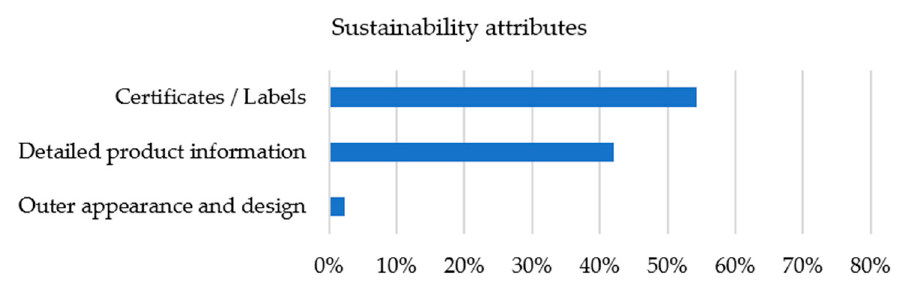
Figure 7. Sustainability attributes when making purchasing decision.